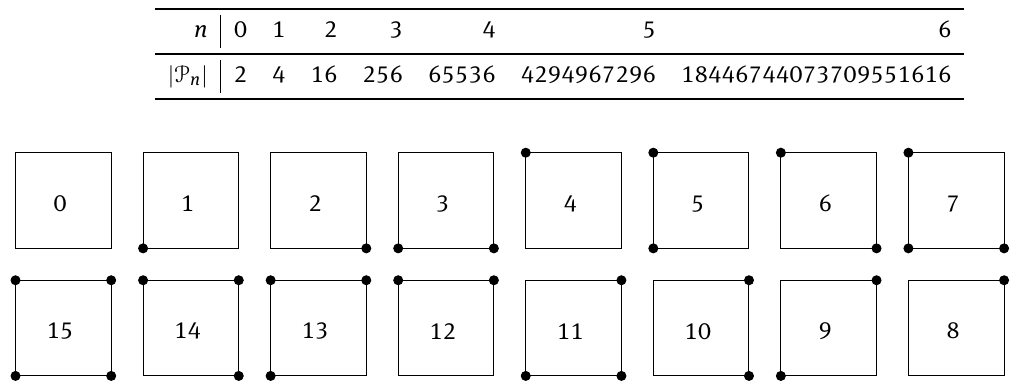
Table 5: Doubly exponential growth of the number | P n | of 0/1 -polytopes in I n .